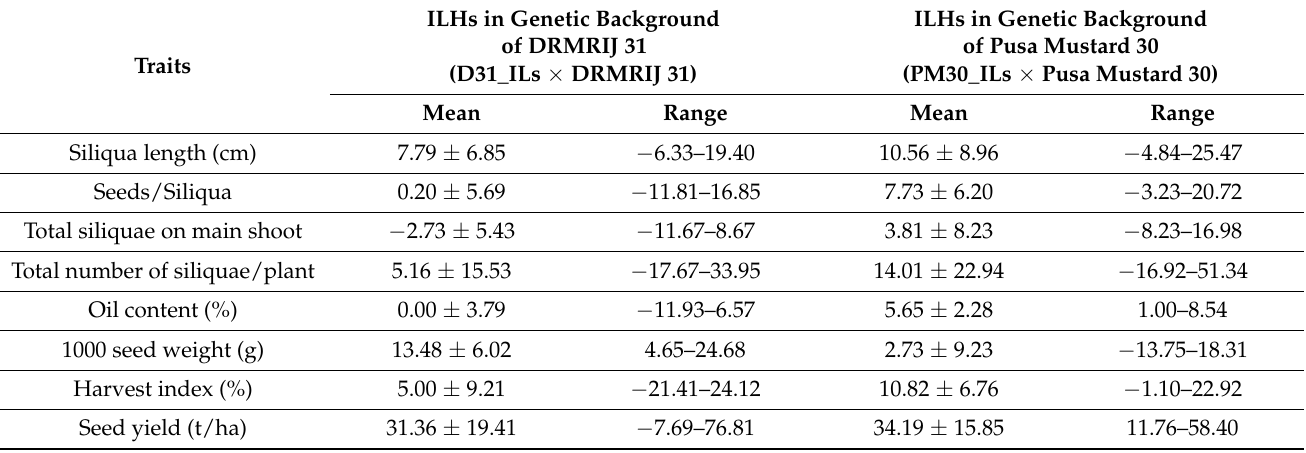
Table 2. Extent of mid-parent heterosis (%) for seed yield and its contributing traits in introgression line hybrids (ILHs) generated from hybridizing B. carinata -derived B. juncea introgression lines with their respective genetic backgrounds.